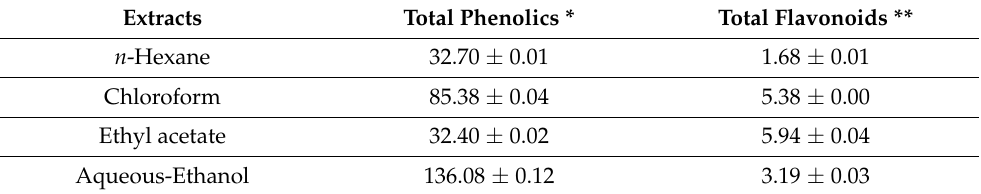
Table 3. Quantitative analyses of the total phenolics and flavonoids contents in S.